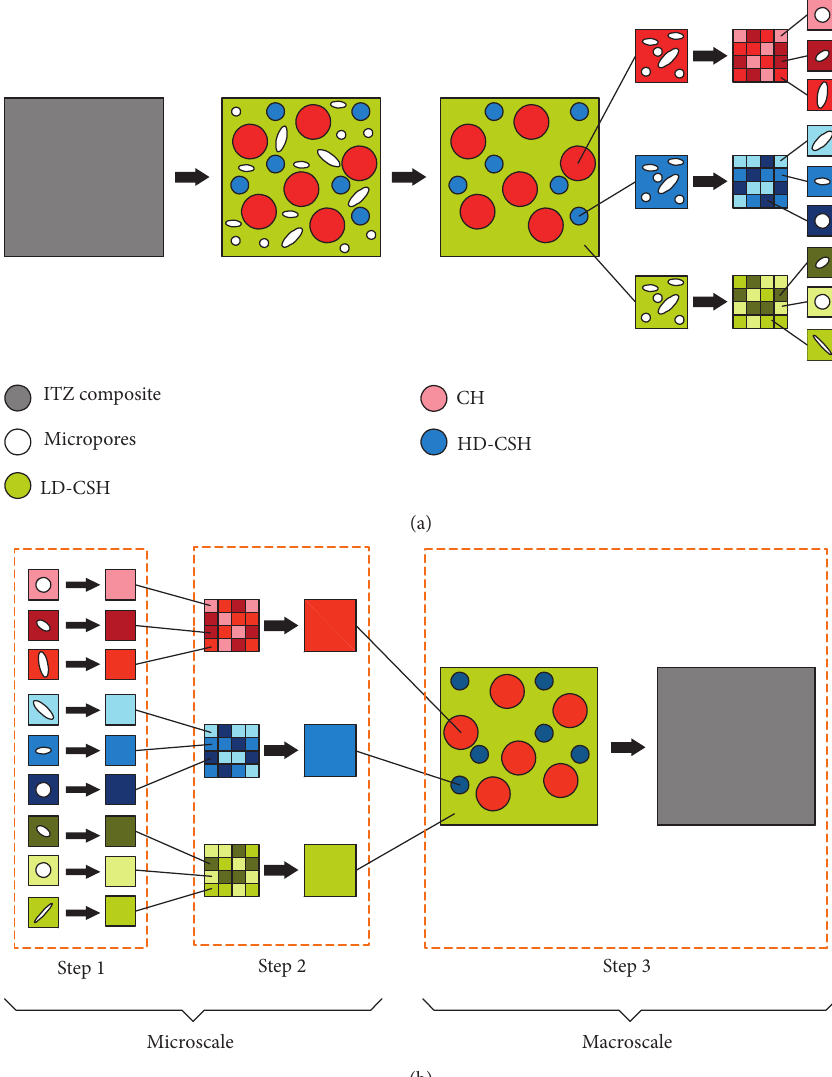
Figure 2: Trans-scale modeling. (a) Trans-scale analyzing procedure. (b) Trans-scale modeling procedure.